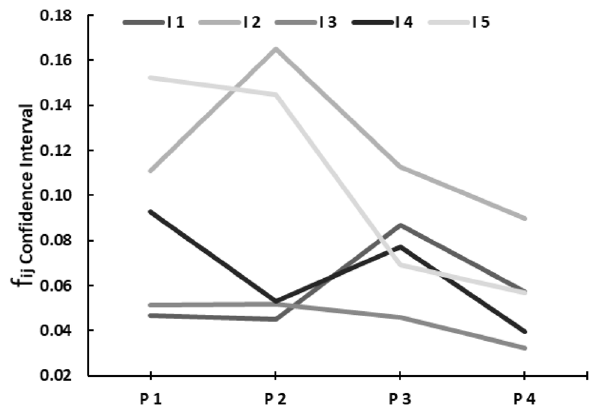
Fig. 9 95% confidence intervals on interwell connectivities ( f ij ) esti- mated by D-CRMP in case I. Subscript i and j stand for injector and producer index in range 1–5 and 1–4, respectively